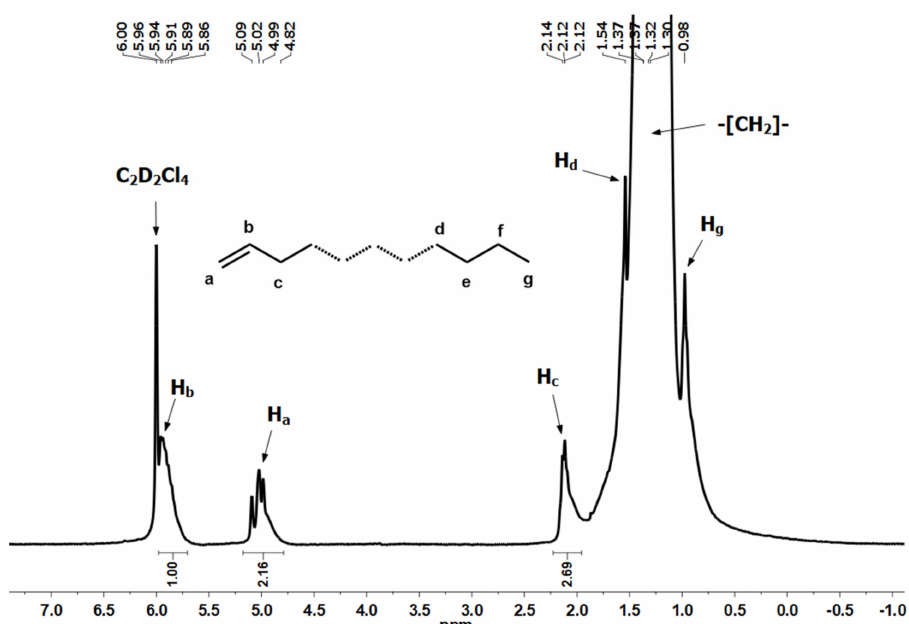
Figure 11. 1 H NMR spectrum of the polyethylene generated using Co1/ MAO (run 5, Table 2); recorded in C 2 D 2 Cl 4 at 100 ◦ C.